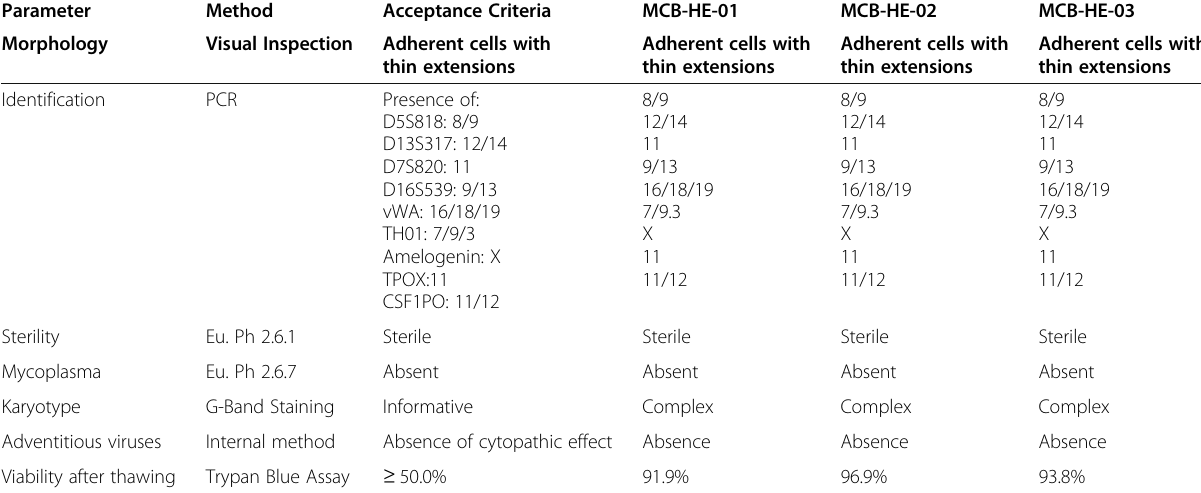
Table 2 MCB specifications. Table summarizing results collected during MCB batch analyses. All MCB batches met